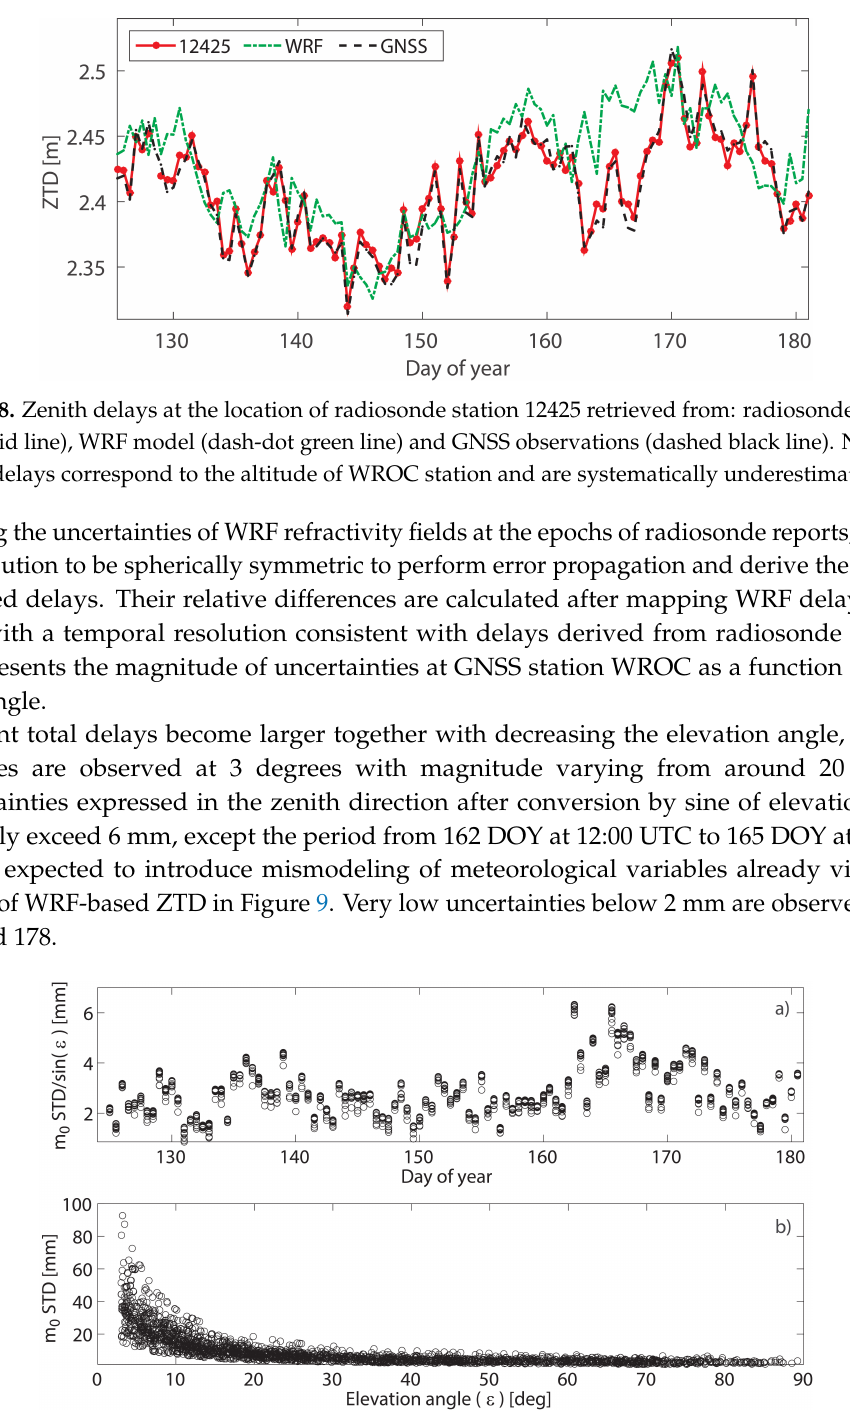
Figure 9. Uncertainties of ray-traced delays due to uncertainty of refractivity: ( a ) for slant delays mapped to zenith by sine of elevation angle with respect to time, ( b ) for slant delays with respect to elevation